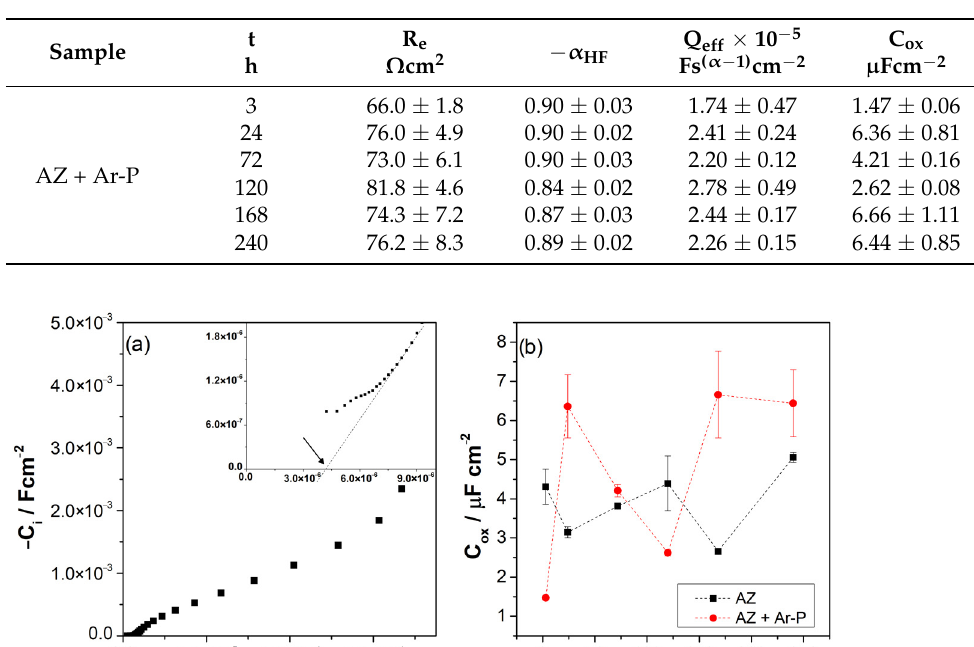
Figure 7. ( a ) A representative Cole-Cole plot of AZ samples after 3 h of immersion, as an example for the determination of C ox ; ( b ) Evolution of complex capacitance (C ox ) for the differently pretreated AZ31 alloy immersed in 0.1 M of Na 2 SO 4 .